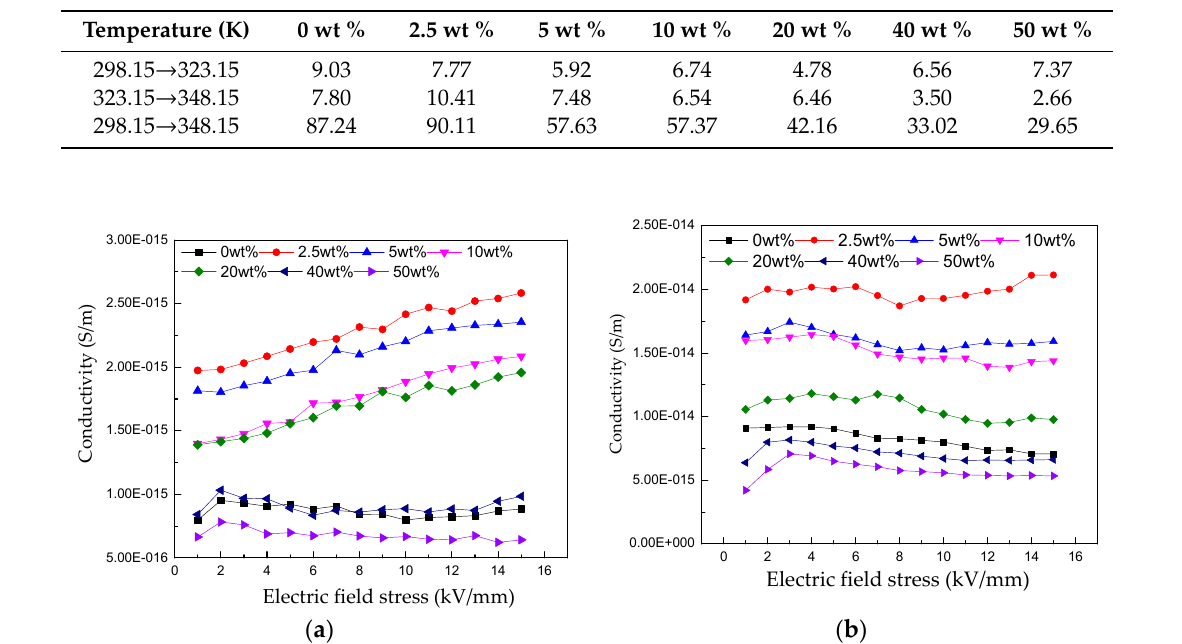
Table 1. α under di ff erent temperature changes.